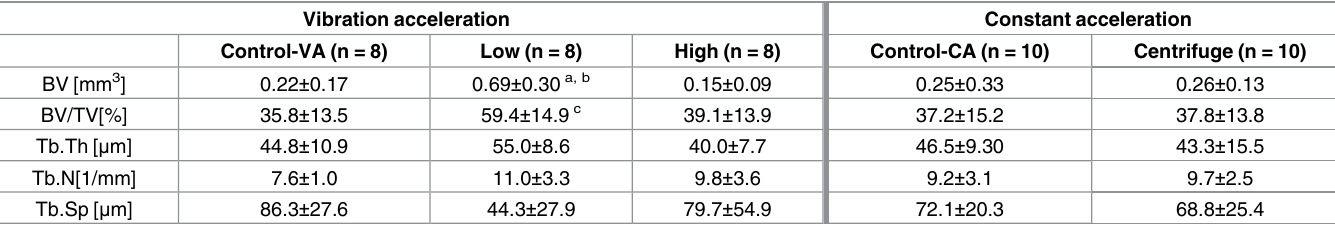
Table 4. Micro-CT analysis of rib fracture sites among vibration acceleration groups and constant acceleration